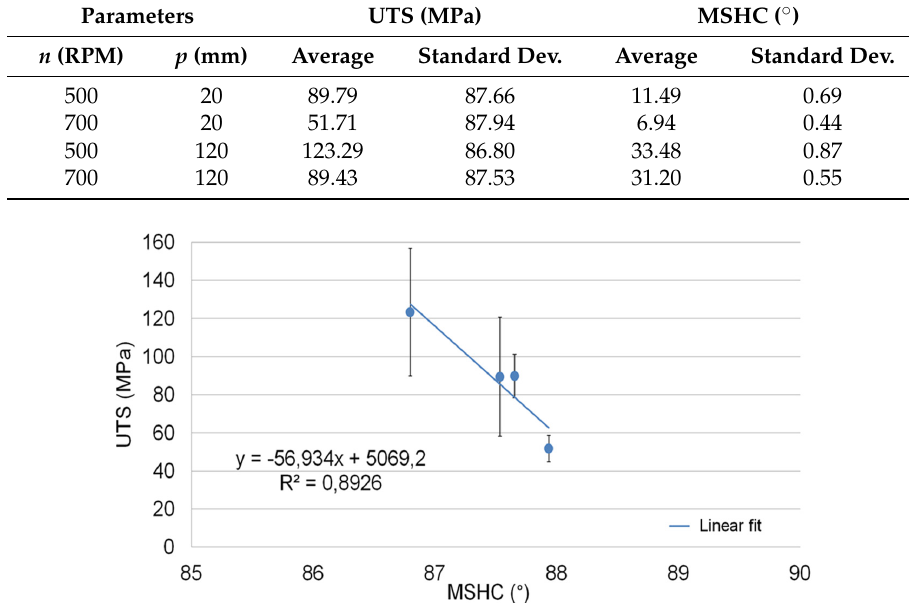
Table 9. UTS and MSHC values used to obtain the empirical model shown in Figure 17.